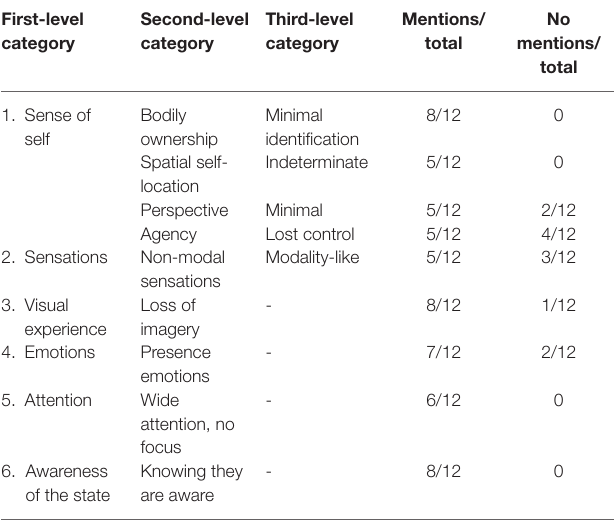
TABLE 10 | Summary of mentions provided to the most frequent third-level and second-level categories. First-level